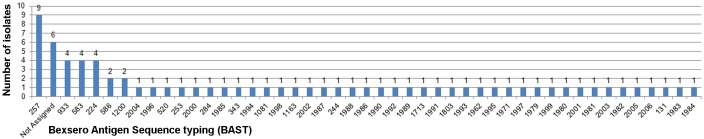
Distribution of Bexsero antigen sequence typing (BAST).